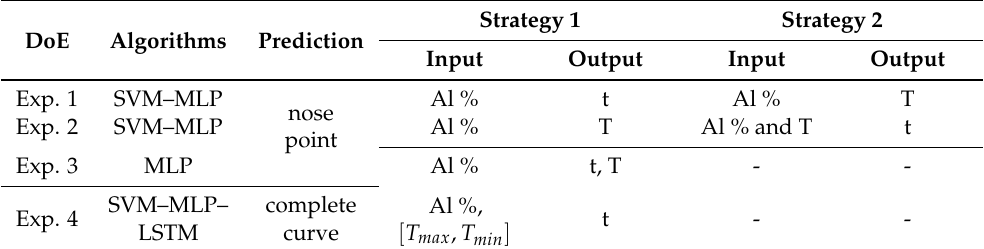
Table 3. Experimental design to predict the nose point and the complete TTT curves with different inputs. Temperature (T) and time (t). Table 2 shows the parameter